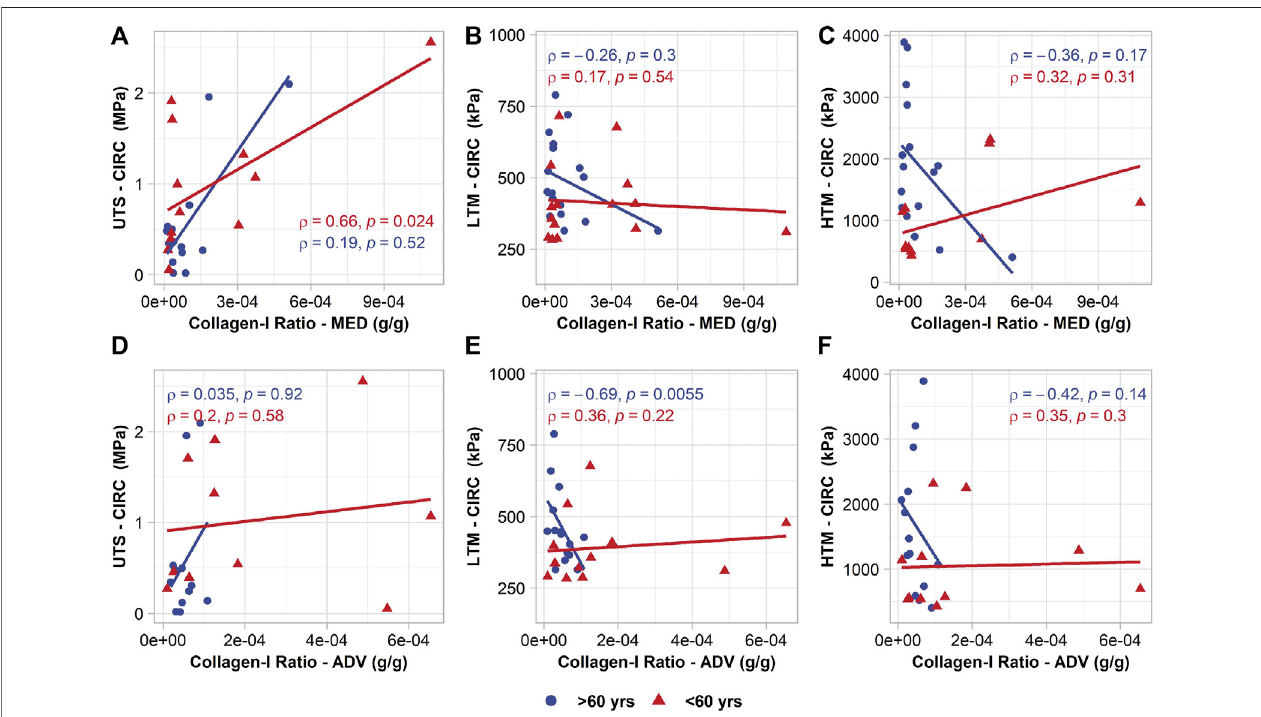
FIGURE 4 | Age-group speci fi c relationships between circumferential mechanical properties and collagen-I ratio in the media (top row) and collagen-I ratio in the adventitia (bottom row). (A,D) circumferential UTS; (B,E) circumferential LTM; (C,F) circumferential HTM.